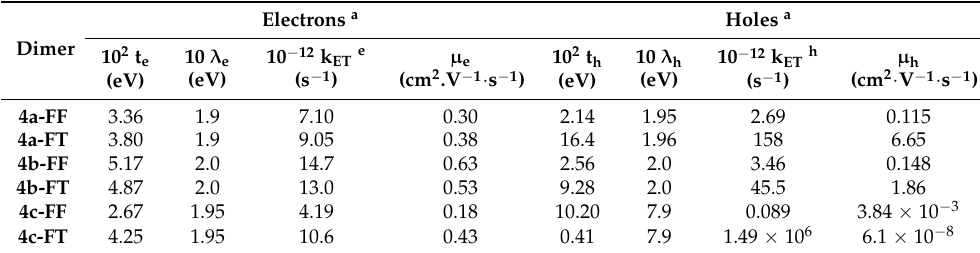
Table 6. Calculated values of the electronic coupling t, the reorganization energy λ , the charge-transfer rate constant k ET , and the relative mobility µ for all cationic dimers from 4a – c . Electrons Dimer